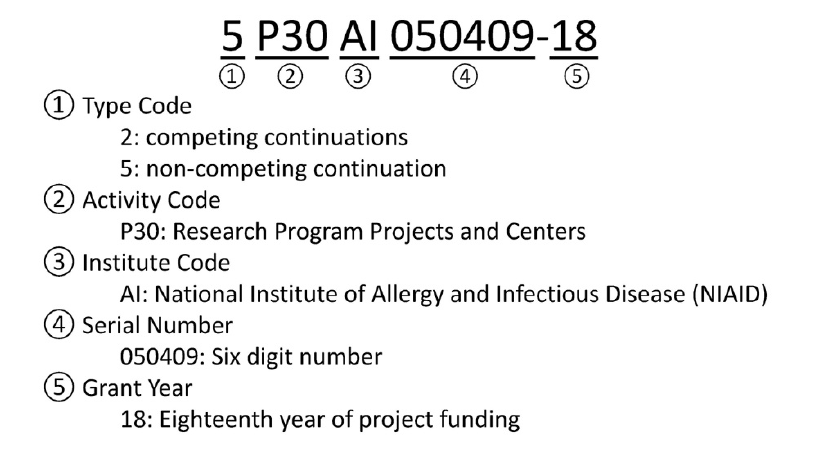
Figure 1 Components of a National Institutes of Health (NIH) grant